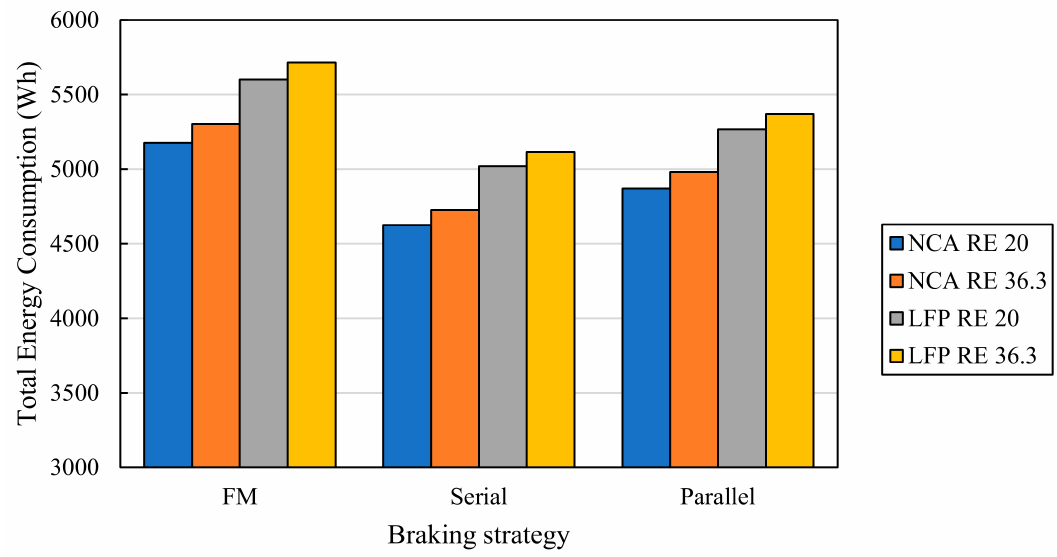
Figure 15. Total energy consumption comparison of RE cases for the complete route.